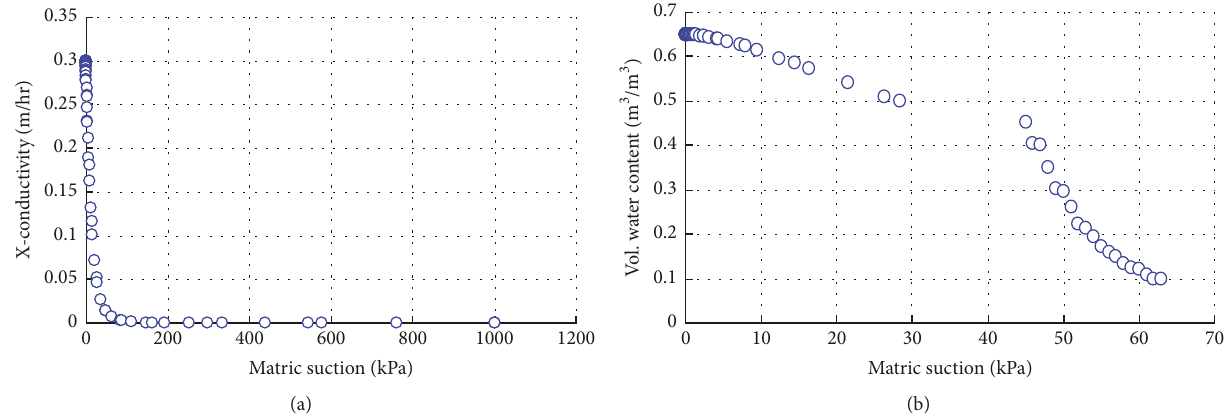
Figure 10: Permeability coefficient (fine material): (a) matric suction versus conductivity and (b) matric suction versus water content.